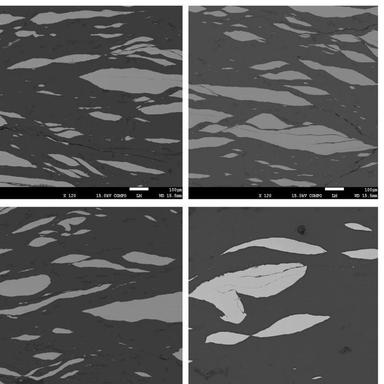
FE-SEM micro-images showing the structure of AFF consolidated Mg/Ni layered composite structure from different locations and at different magnifications. In these backscattered images, the magnesium matrix is addressed by grey contrast and fragments of nickel foil layers by brighter contrast.